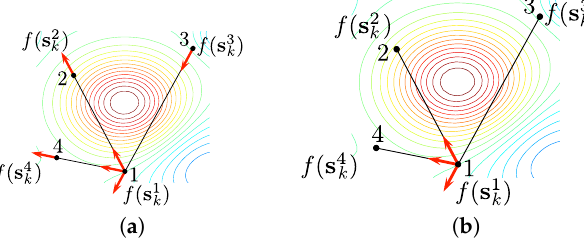
( k ) = s 1 , s 2 , s 3 , s 4 , i.e., n = 4, and k k k } k S {